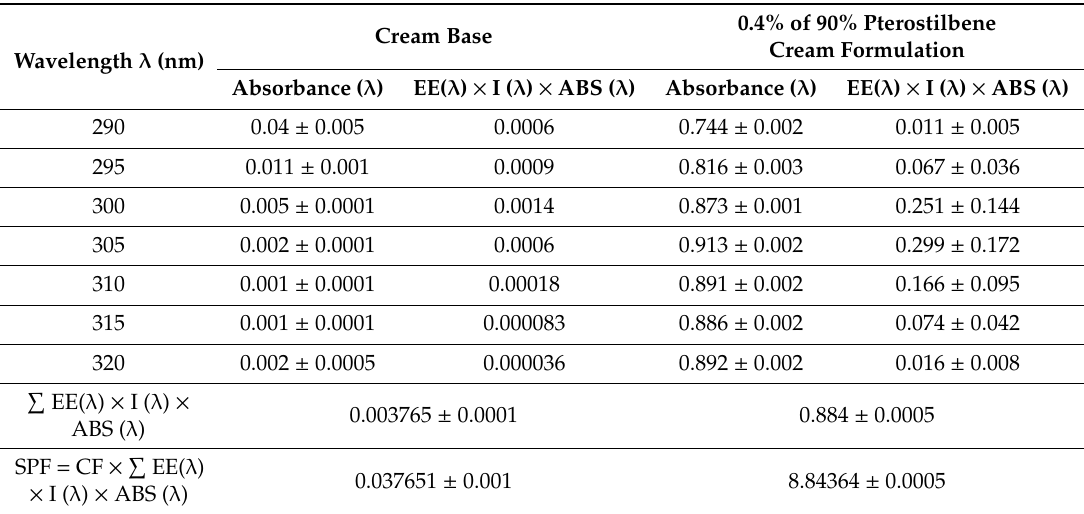
Table 2. SPF determination of pterostilbene cream formulation in comparison to the base